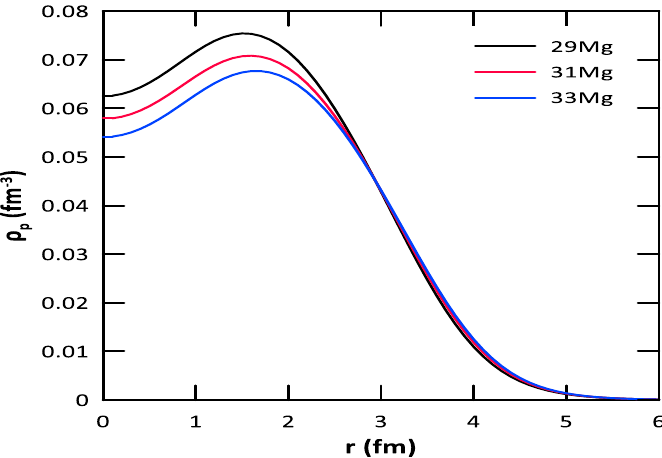
Fig. 5(a): The relation between proton density (fm -3 ) and position r(fm) for 29,31,33 Mg nuclei.